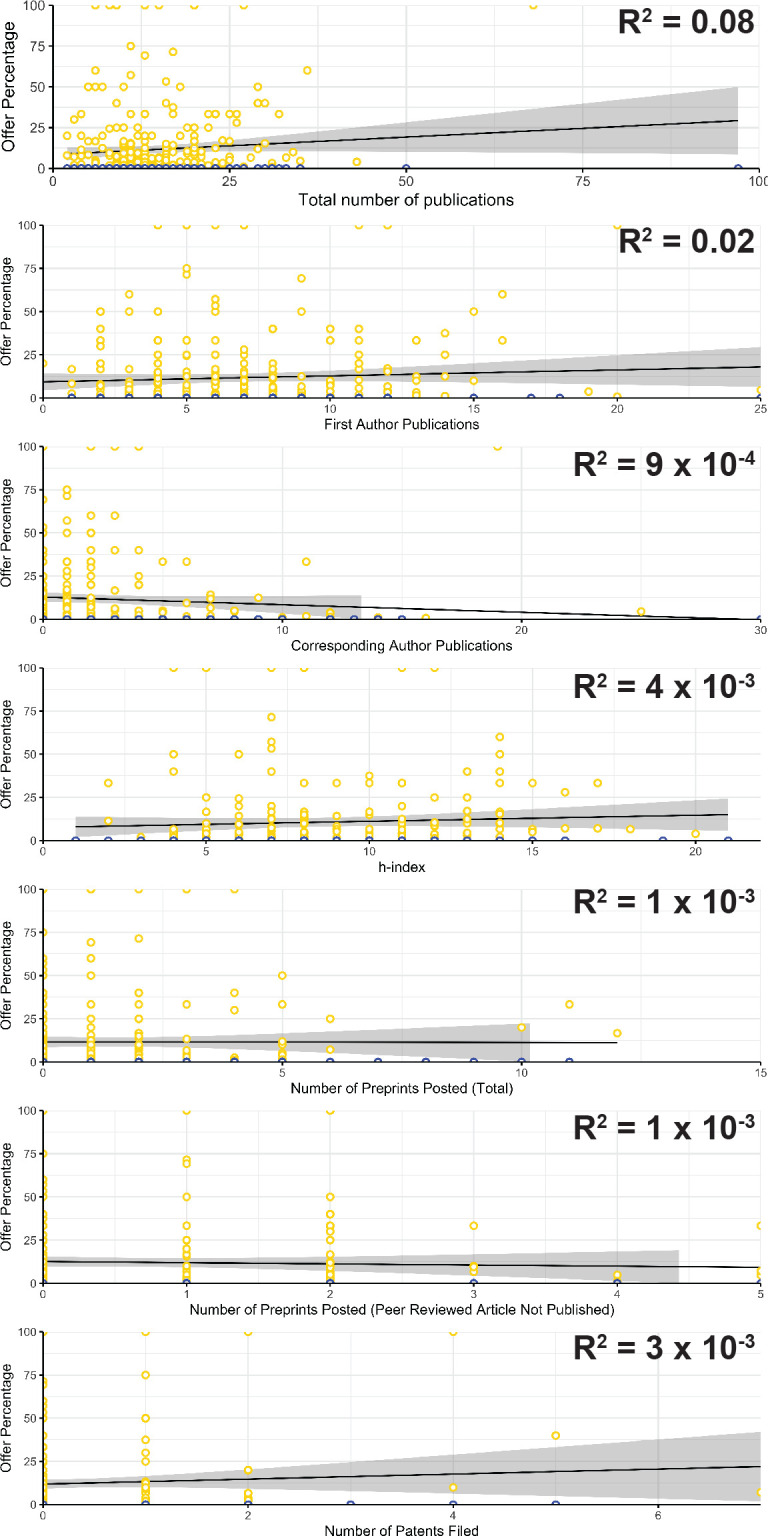
Correlations between offer percentage and a number of traditional scholarly metrics.Pearson correlation coefficient (R2) between offer percentage total number of publications (top), number of first author publications (second graph), number of corresponding author publications (third graph), h-index (fourth graph), preprints posted (overall total, fifth graph; as well as those in which the peer-reviewed article was not published at the time of application, sixth graph), and number of patents filed, bottom graph). Yellow dots represent candidates with an offer, blue dots received no offers; black line represents linear best-fit and gray fill represents the 95% confidence interval for that fit. We examined several other publication metrics and found no correlation with the number of offers. Specifically, the total number of publications (R2 = 8×10−2), the number of first author (R2 = 2×10−2), the number of corresponding author publications (R2 = 9×10−4), and h-index (R2 = 4×10−3) did not significantly correlate with offer percentage.